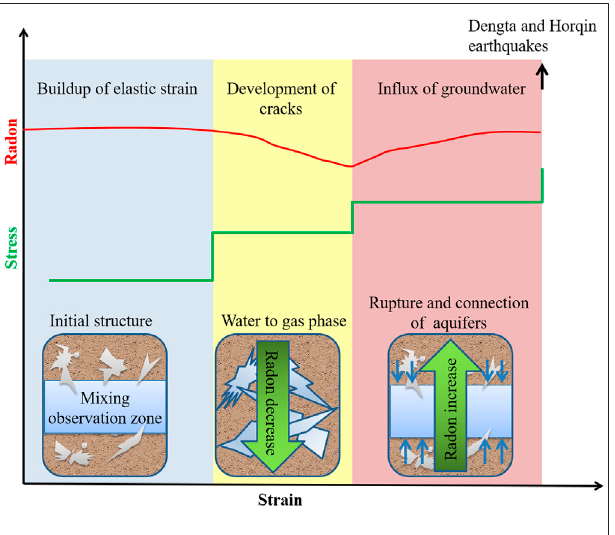
FIGURE 7 | Simpli fi ed sketch illustrating the model of radon concentration change caused by the Dengta and Horqin